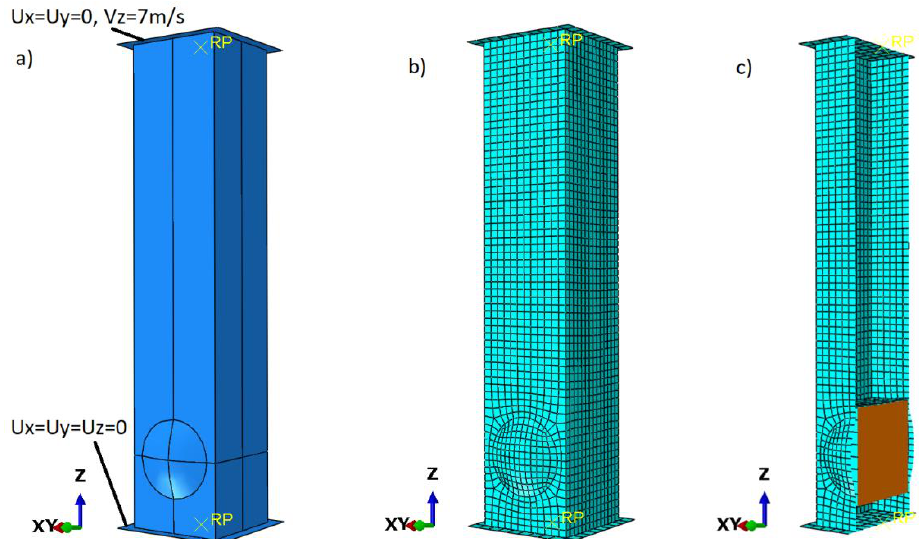
Figure 4. Numerical model ( a ) Boundary conditions; ( b ) discretized numerical model; ( c ) cross-section of the discretized foam-filled model.